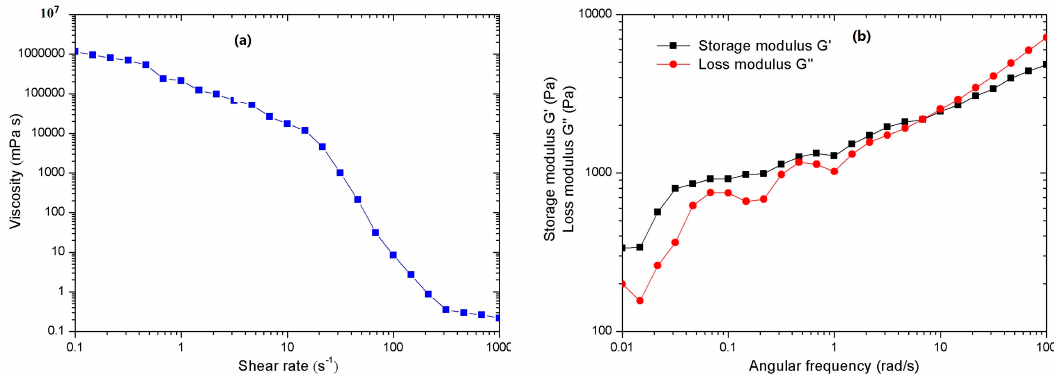
Figure 3. Rheological behaviour of the raw materials at 160 °C: ( a ) the viscosity as a function of shear rate; ( b ) the storage modulus (G ′ ) and loss modulus (G ″ ) as a function of frequency.